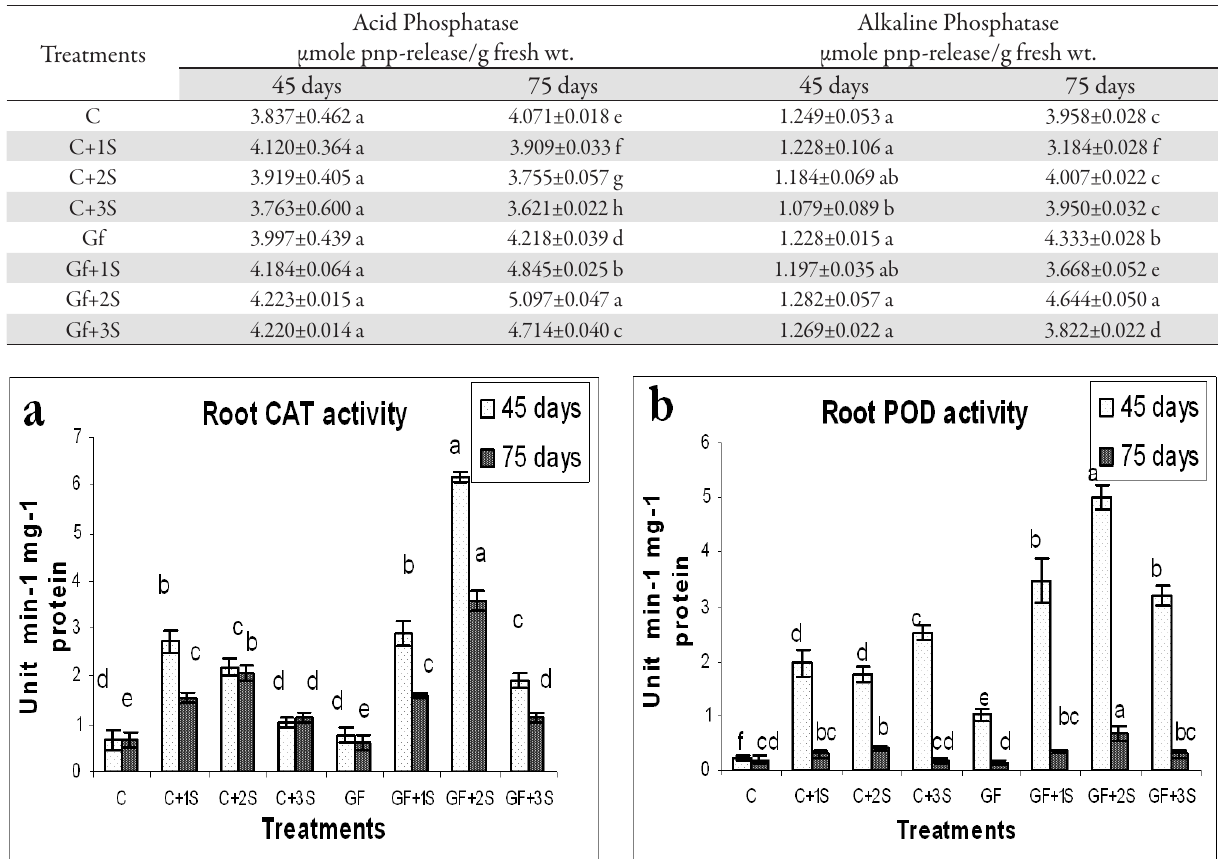
Fig. 2. CAT and POD activity from roots of Allium sativum L. after 45 and 75 days of AM